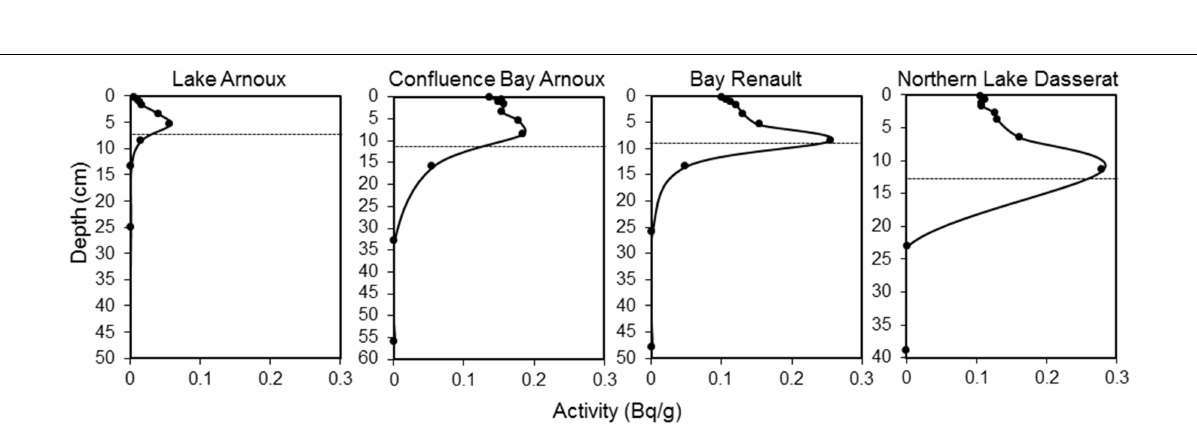
FIGURE 2 | Ln 210 Pb ex as a function of depth (cm) for each of the four cores. Due to some variability in the 210 Pb profiles from Lake Arnoux, only the values that followed the expected decreasing trend in concentration as a function of depth were included in the model (4 data points excluded).